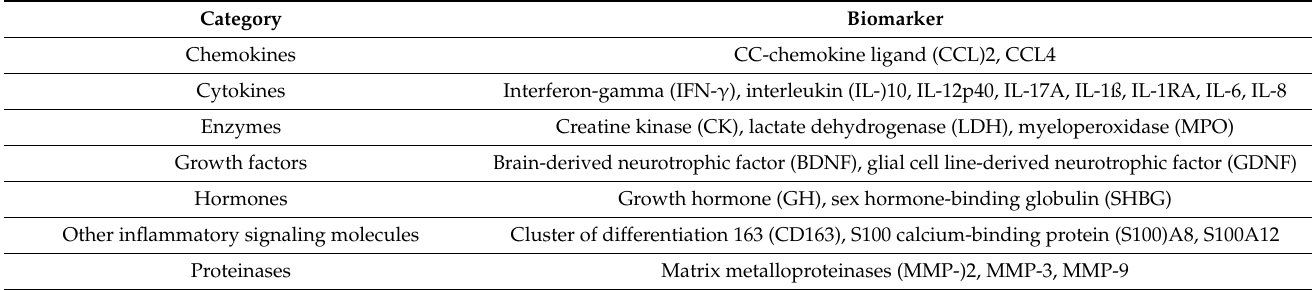
Table 2. Blood-based biomarker panel and associated